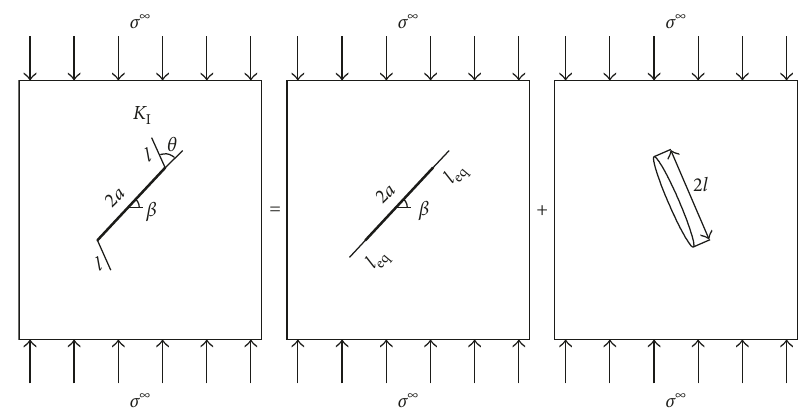
Figure 5: Computation of the SIF at the wing crack tip by using the superposition technique [17].